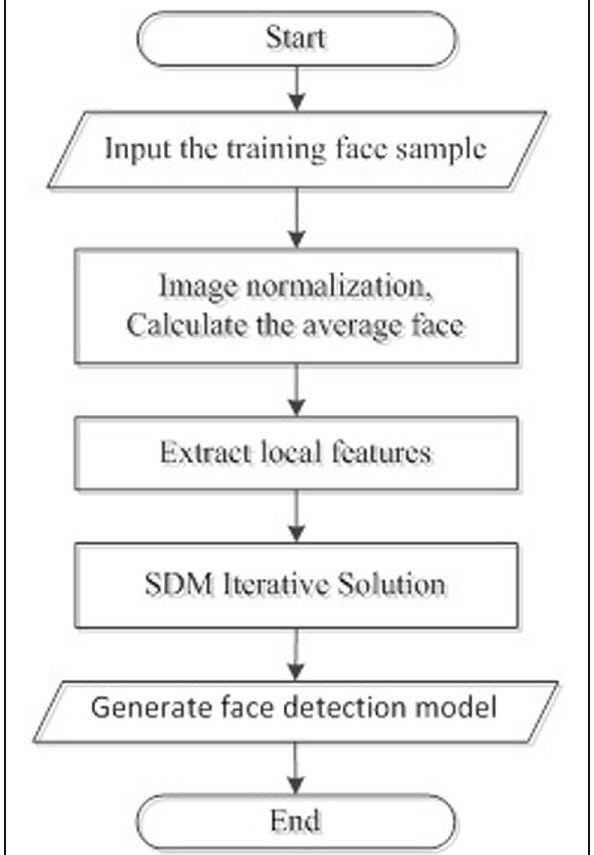
Fig. 15 The face alignment process based on